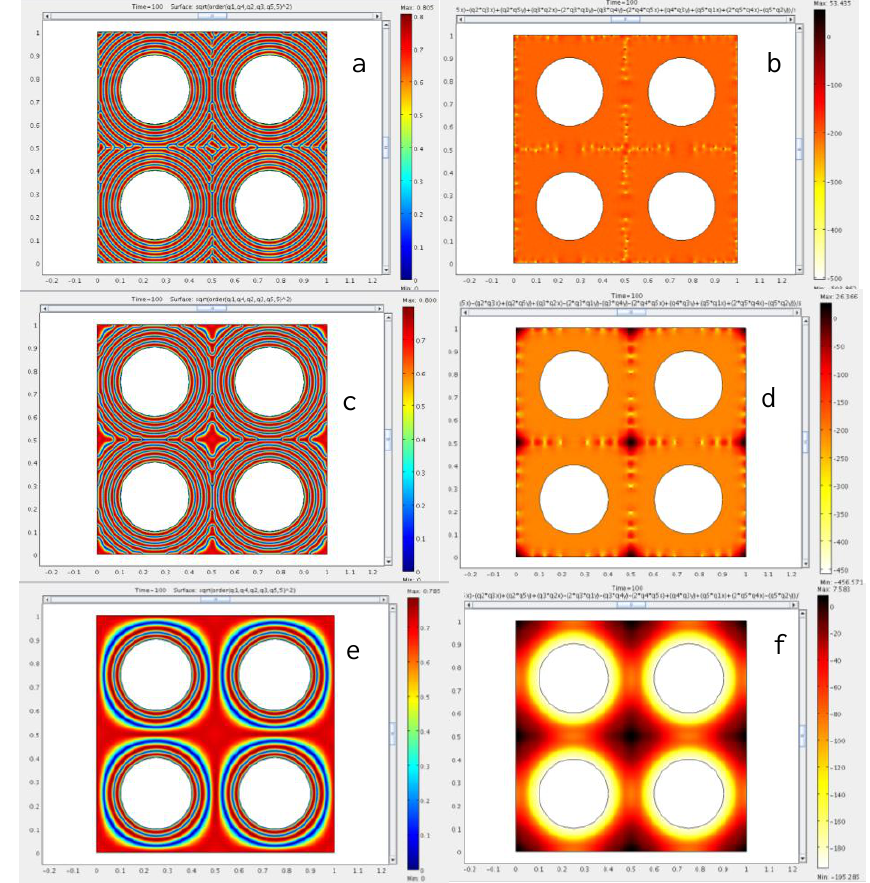
Figure 5. Simulation results for chiral nematic self assembly at dimensionless time t = 100, for length scales ξ/p = 0.05, h/p = 20, and U = 6 for varying  . Surface plots of 0 o out-of-plane component |n | of the director field (left) and chiral order parameter q (right). z The elastic anisotropies are 1 (a),(b); 5 (c),(d); 21